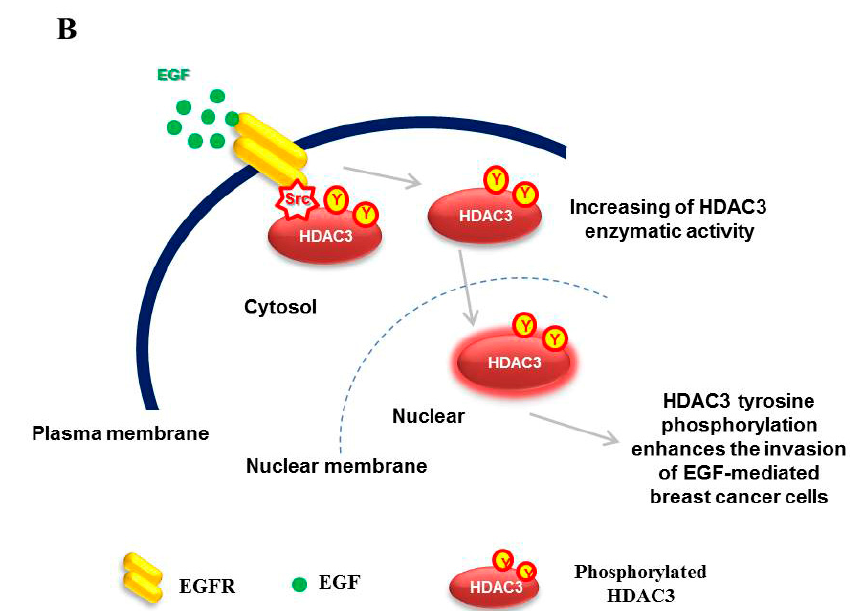
Figure 6. c-Src-mediated HDAC3 phosphorylation enhances the invasion of breast cancer cells. ( A ) siRNA targeting c-Src was transiently transfected into either the sh-Control or sh-HDAC3-expressed stable MDA-MB-231 cells, and after 24 h, rsh-HDAC3 WT or rsh-HDAC3 Y328/331 was overexpressed for another 36 h. Cell invasion was measured using the Matrigel system, and results are presented as the fold of the control (left panel). Results are expressed as means ± SD calculated from three independent experiments. * P ≤ 0.05. Small interfering RAN against c-Src (si-c-Src), Flag-rsh-HDAC3 wt , and Flag-rsh-HDAC3 Y328/331 were validated with indicated antibodies using Western blot analysis (right panel). ( B ) Model of our findings. EGF stimulation triggers the formation of the EGFR–c-Src–HDAC3 heterocomplexes near the plasma membrane, induces the EGFR–c-Src-mediated phosphorylation of Y328 and Y331 on HDAC3, resulting in the induction of HDAC3 enzymatic activation. Phosphor-HDAC3Y328/331 was translocated into the nucleus. The association of EGFR–c-Src-HDAC3, consequentially, enhanced the invasiveness of breast cancer cells.